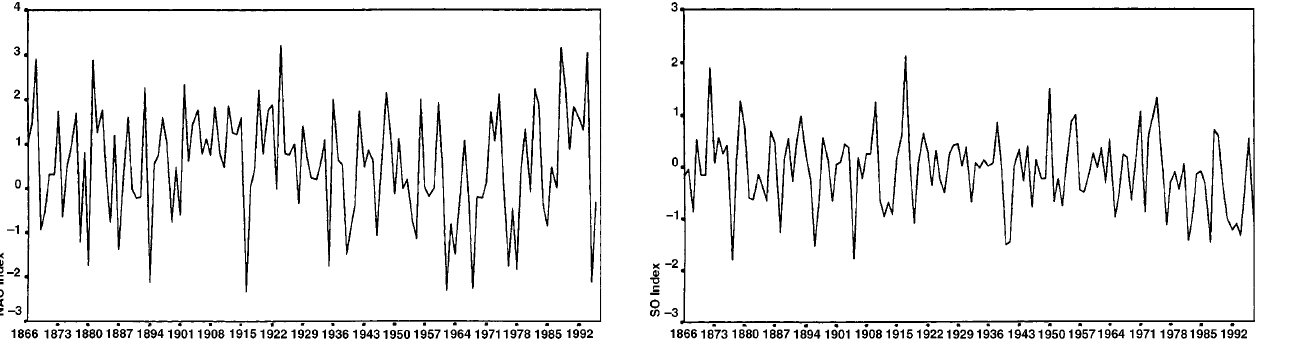
Fig. 2. Annual index of the Southern Oscillation (1866–1997) based on the mean normalized sea pressure di(cid:128)erence between Tahiti